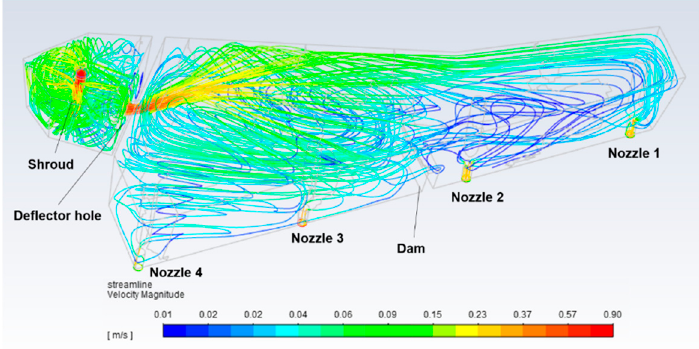
Figure 9. Streamline of liquid steel in the tundish obtained by the numerical simulation.